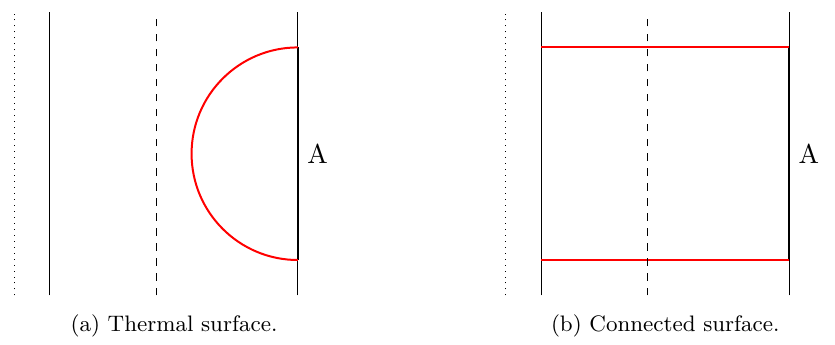
Figure 2 . The possible configurations of bulk extremal